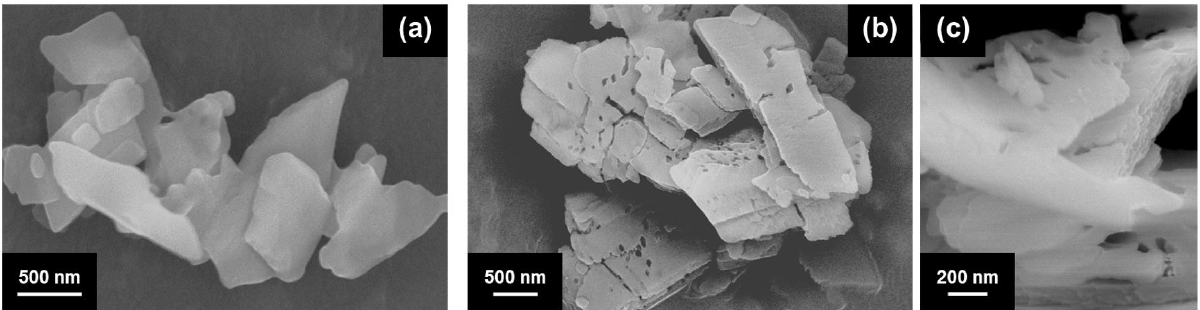
Figure 4. SEM images of both the pristine particles of (Li 2 )(Li,H)- o -DHT ( a ) and the recovered powder after thermal treatment at 290 °C during 20 h ( b , c ).